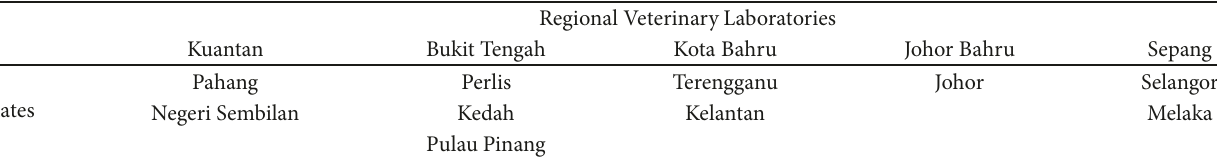
Table 1: Sources of samples to the five Regional Veterinary Laboratories in Peninsular Malaysia.